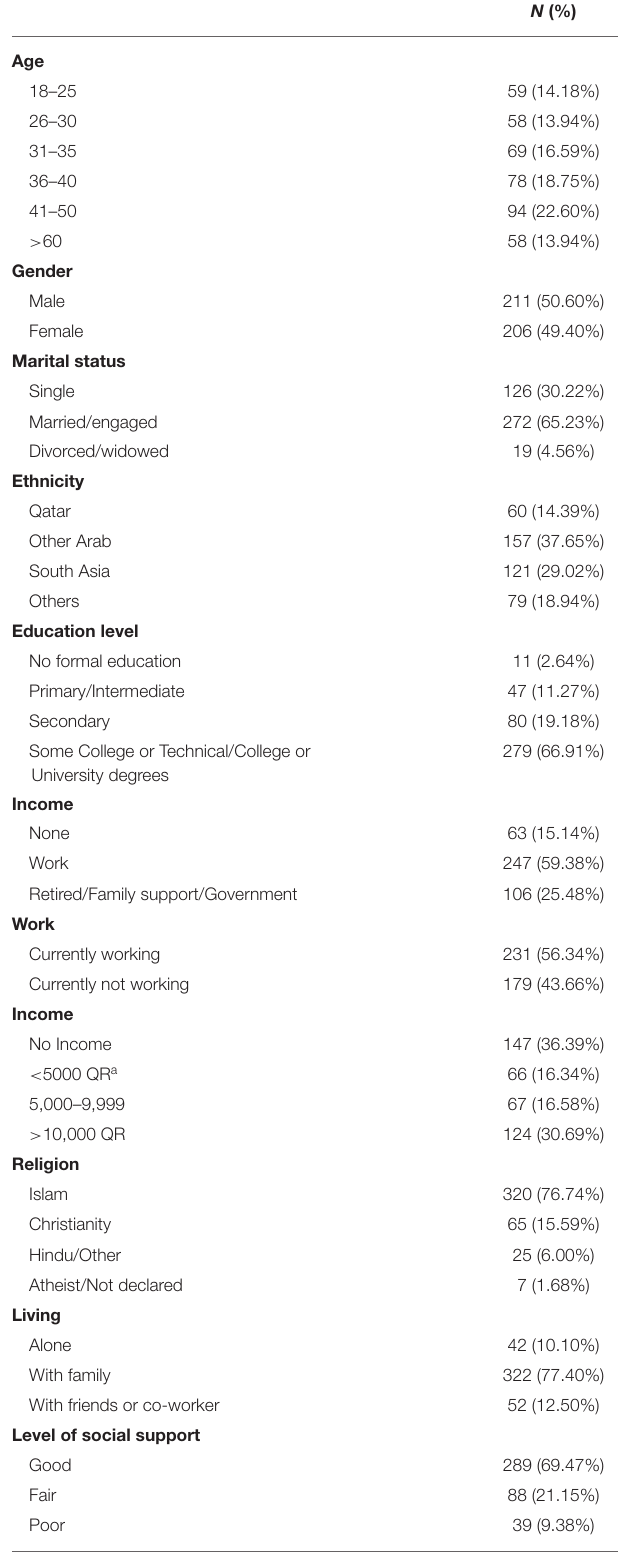
TABLE 1 | Patients’ socio-demographic and clinical characteristics ( N =